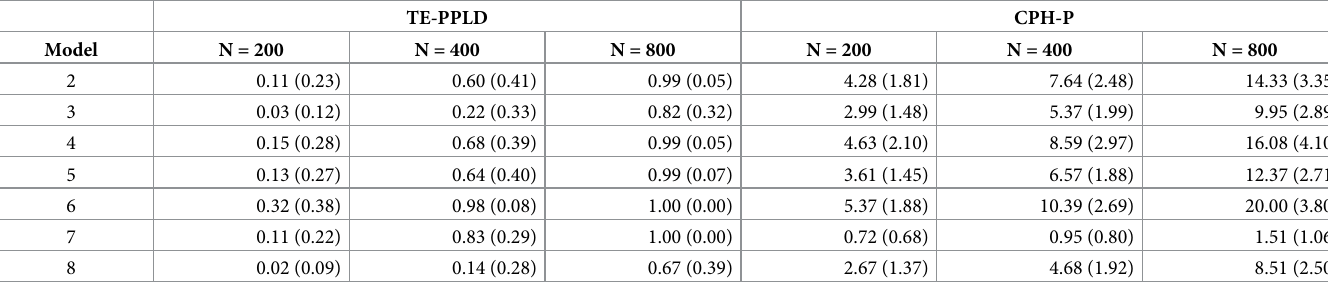
Table 4. Summary of sampling distributions of TE-PPLD, CPH-P, respectively, for the baseline models under H A .